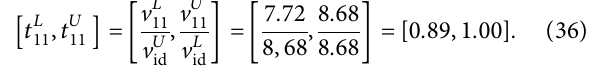
Table 11 indicates the Rough Normalized Matrix.